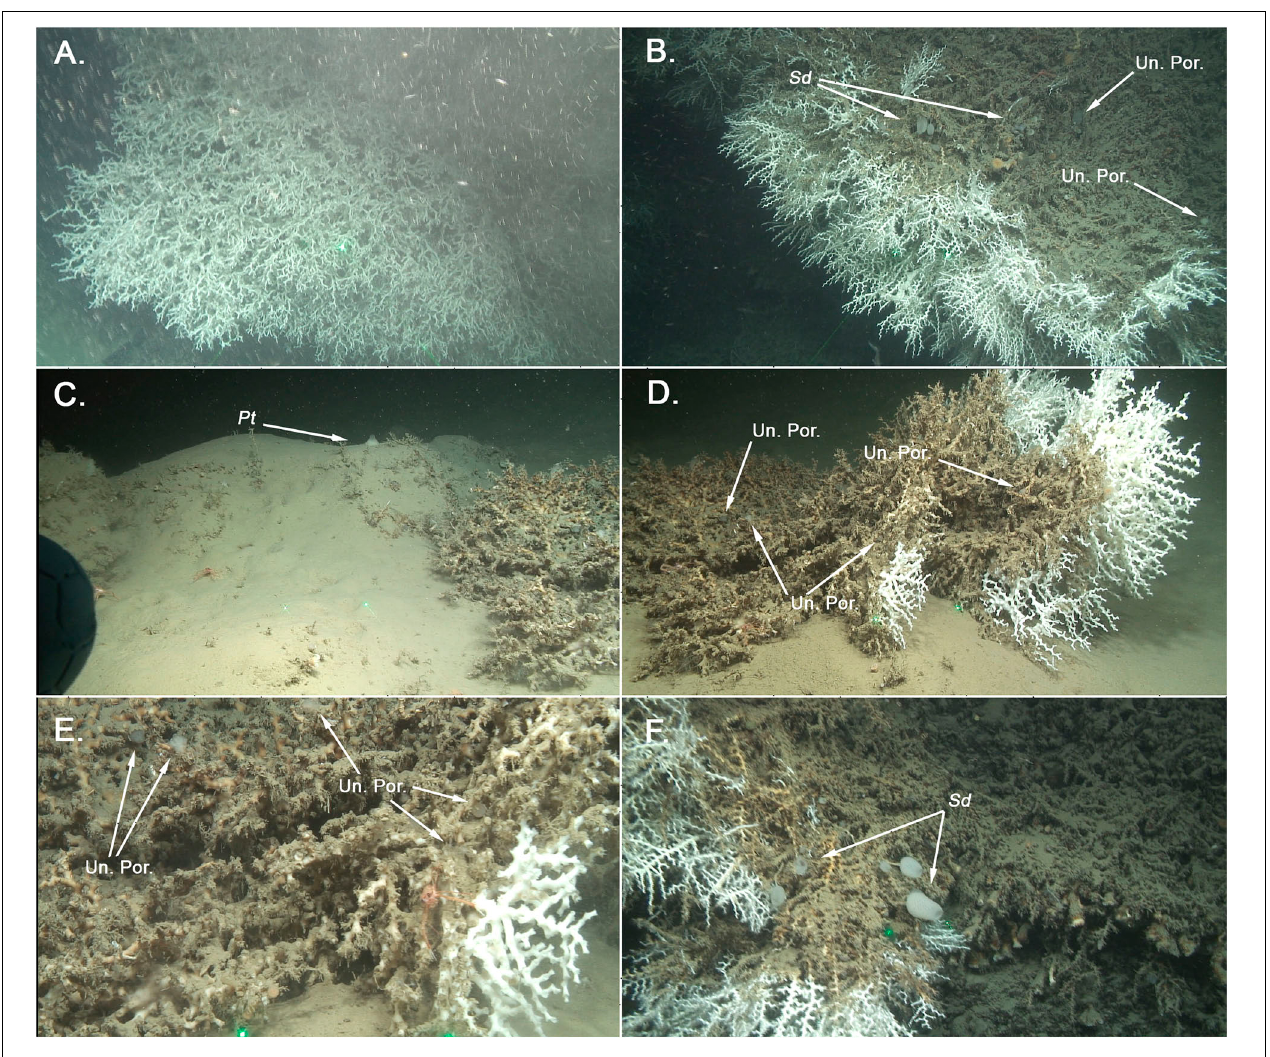
FIGURE 2 | (A) Colony of Lophelia pertusa growing on a vertical wall on the Blanes Canyon at ca. 840 m depth (41 ◦ 34 (cid:48) 872 (cid:48)(cid:48) N 02 ◦ 50 (cid:48) 986 (cid:48)(cid:48) E). (B) Partially death colony of Madrepora oculata , growing on a vertical wall at ca. 600 m depth (41 ◦ 37 (cid:48) 642 (cid:48)(cid:48) N 02 ◦ 51 (cid:48) 4265 (cid:48) E). Sd signals de presence of the Sponge Sympagella delauzei , whereas Un. Por. correspond to unidentified sponges. (C) Partially buried colony of M. oculata (rear). Pt signals an individual of Polymastia tissieri growing amidst the sand/rubble matrix at ca. 680 m depth at the eastern flank of the canyon (41 ◦ 30 (cid:48) 338 (cid:48)(cid:48) N 02 ◦ 56 (cid:48) 04 (cid:48)(cid:48) E). (D) Partially buried colony of M. oculata (front). Un. Por. correspond to unidentified sponges. (E) Close up of the partially buried colony, where a Munida sp. (reddish crab) can be seen alongside unidentified sponges (Un. Por.). (F) Sympagella delauzei ( Sd ) individuals growing onto the dead skeleton of a M. oculata colony at ca. 600 m depth (41 ◦ 37 (cid:48) 642 (cid:48)(cid:48) N 02 ◦ 51 (cid:48) 4265 (cid:48)